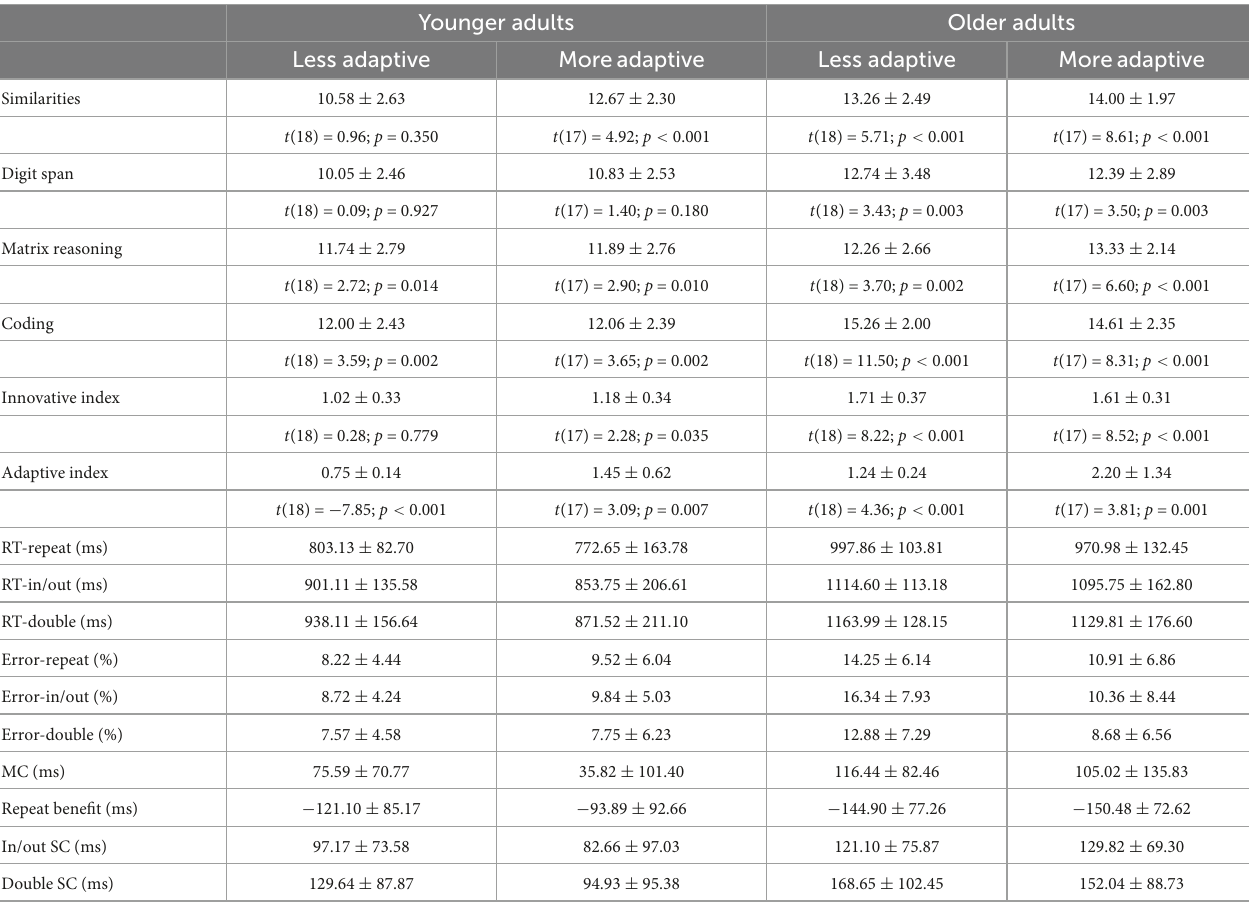
TABLE 4 Summary of behavioral data for the more and less adaptive groups (mean ± SD and t -test results for the difference from population average in test scores–for the WAIS-IV subtests’ scaled scores the corresponding age-group’s mean score is 10, and for the two creativity-styles’ index the corresponding age-group’s mean score is